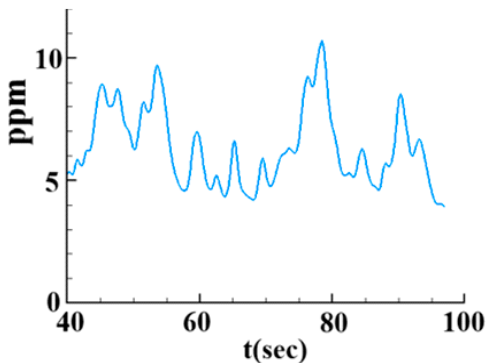
Figure 11. The schematic shows the instantaneous variation of mass fraction of SO 2 ( Y SO2 ) at outlet for the full-scale tower.